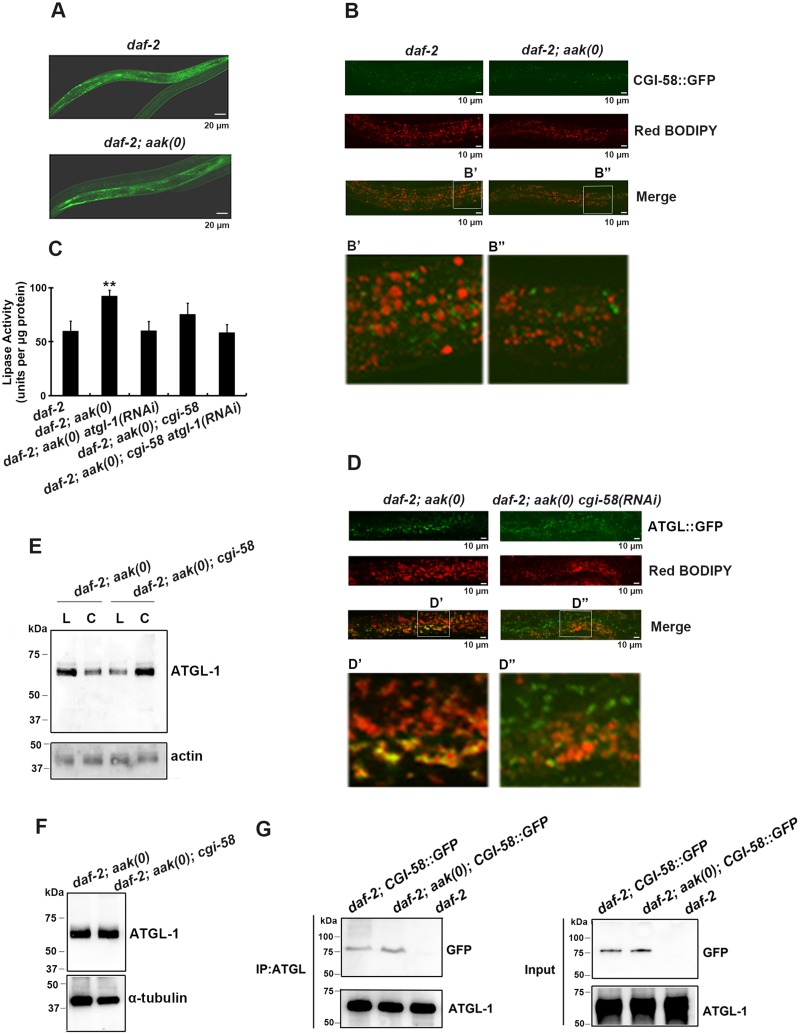
CGI-58 interacts with ATGL-1 and tethers it to the lipid droplets.
(A) CGI-58::GFP was expressed in the hypodermis and the intestine at comparable levels in both control daf-2 and daf-2; aak(0) mutant dauer larvae. Both strains carry the same ex[Pcgi-58::cgi-58::GFP; rol-6(gf)] transgene (See Materials and Methods). Scale bar = 20 μm. (B) CGI-58::GFP localizes to the surface of the lipid droplets at dauer day 0 (48 hours after being shifted to 25°C at the L1 stage) in both daf-2 and daf-2; aak(0) mutant dauers. Both strains carry the same ex[Pcgi-58::cgi-58::GFP; rol-6(gf)] transgene. Scale bar = 10μm. Insets (B' and B") were generated by selecting the same size of frame for each image followed by proportionate amplification to the same magnification. (C) Optimal ATGL-1 lipase activity requires cgi-58. ATGL-1-dependent lipase activity was determined in daf-2; aak(0) mutant dauer larvae with wild type or compromised cgi-58/atgl-1 function. ** indicates statistical significance (P<0.01) compared to all three of the other genotypes. Error bars indicate SD of three independent experiments. (D) Elimination of cgi-58 resulted in the dissociation of ATGL-1 from the lipid droplets. Both strains carry the same hjIs67[Patgl-1::atgl-1::GFP] transgene. Scale bar = 10μm. Insets (D' and D") were generated by selecting the same size of frame for each image followed by proportionate amplification to the same final magnification. (E) ATGL-1 association with the lipid droplets is dependent on appropriate CGI-58 levels. Immunoblot analysis was used to determine the levels of ATGL-1 in isolated lipid droplets (L) and cytoplasm (C) obtained from total day 0 dauer extracts of each genotype. Protein concentration was measured and 30μg of total protein was loaded in each sample lane. Actin was used as a loading control for the total protein level. (F) CGI-58 does not contribute to ATGL-1 stability in AMPK mutant dauers. ATGL-1 levels were determined by immunobloting using anti-ATGL-1 antisera in lysates obtained from AMPK mutants with or without cgi-58. (G) CGI-58 physically interacts with ATGL-1 in vivo in both control and AMPK mutant dauers. Co-immunoprecipitations were performed with daf-2 and daf-2; aak(0) day 0 dauer larvae carrying the same ex[Pcgi-58::cgi-58::GFP;rol-6(gf)] transgene using anti-ATGL-1 serum for pull down and blotted with anti-GFP serum.